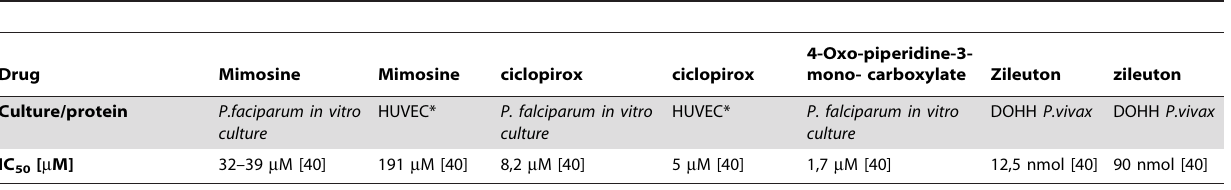
Table 2. IC 50 values of different iron chelators determined in in vitro cultures of P. falciparum and human cell lines compared